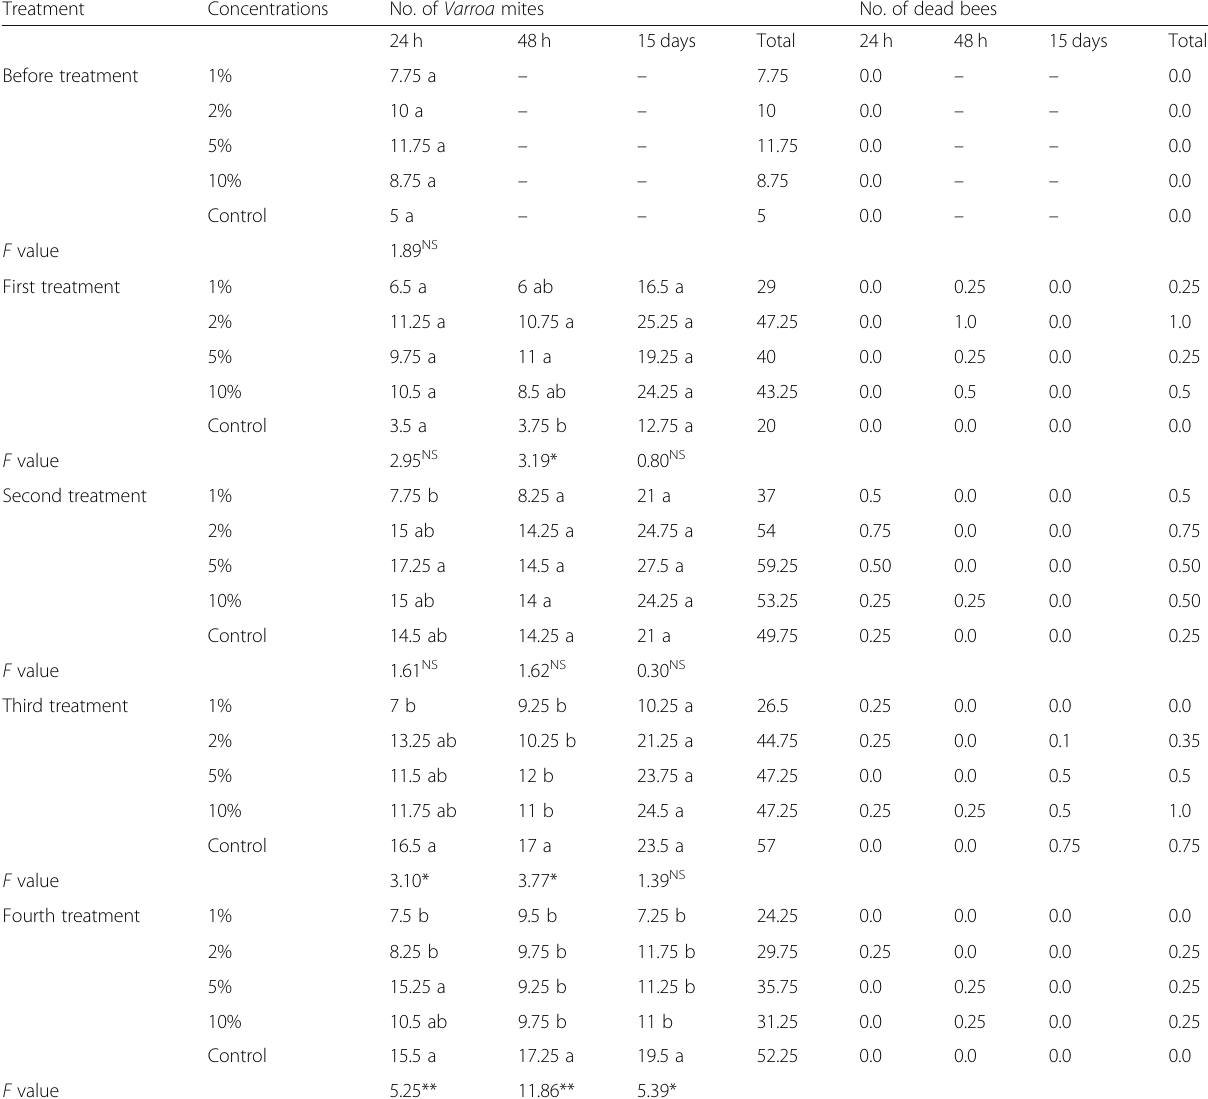
Table 2 Effect of different concentrations of the jatropha oil on the mean number of dead Varroa mites and adult bee fallen on the sheet Treatment Concentrations Before